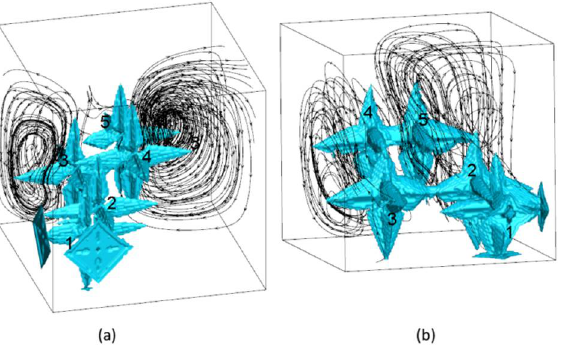
Figure 8. Morphology and streamline distribution for multiple 3D dendrites: ( a ) static state, and ( b ) moving state.